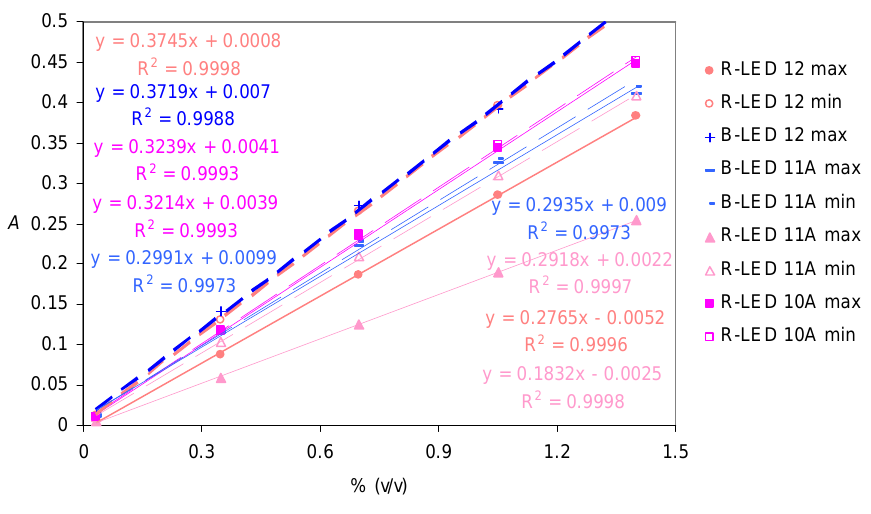
Figure 3. Linearity of the detector’s responses in the range of the blue light (B-LED) and the red light (R-LED) for cells 10a, 11a and 12 at minimum (min) and maxim (max) light